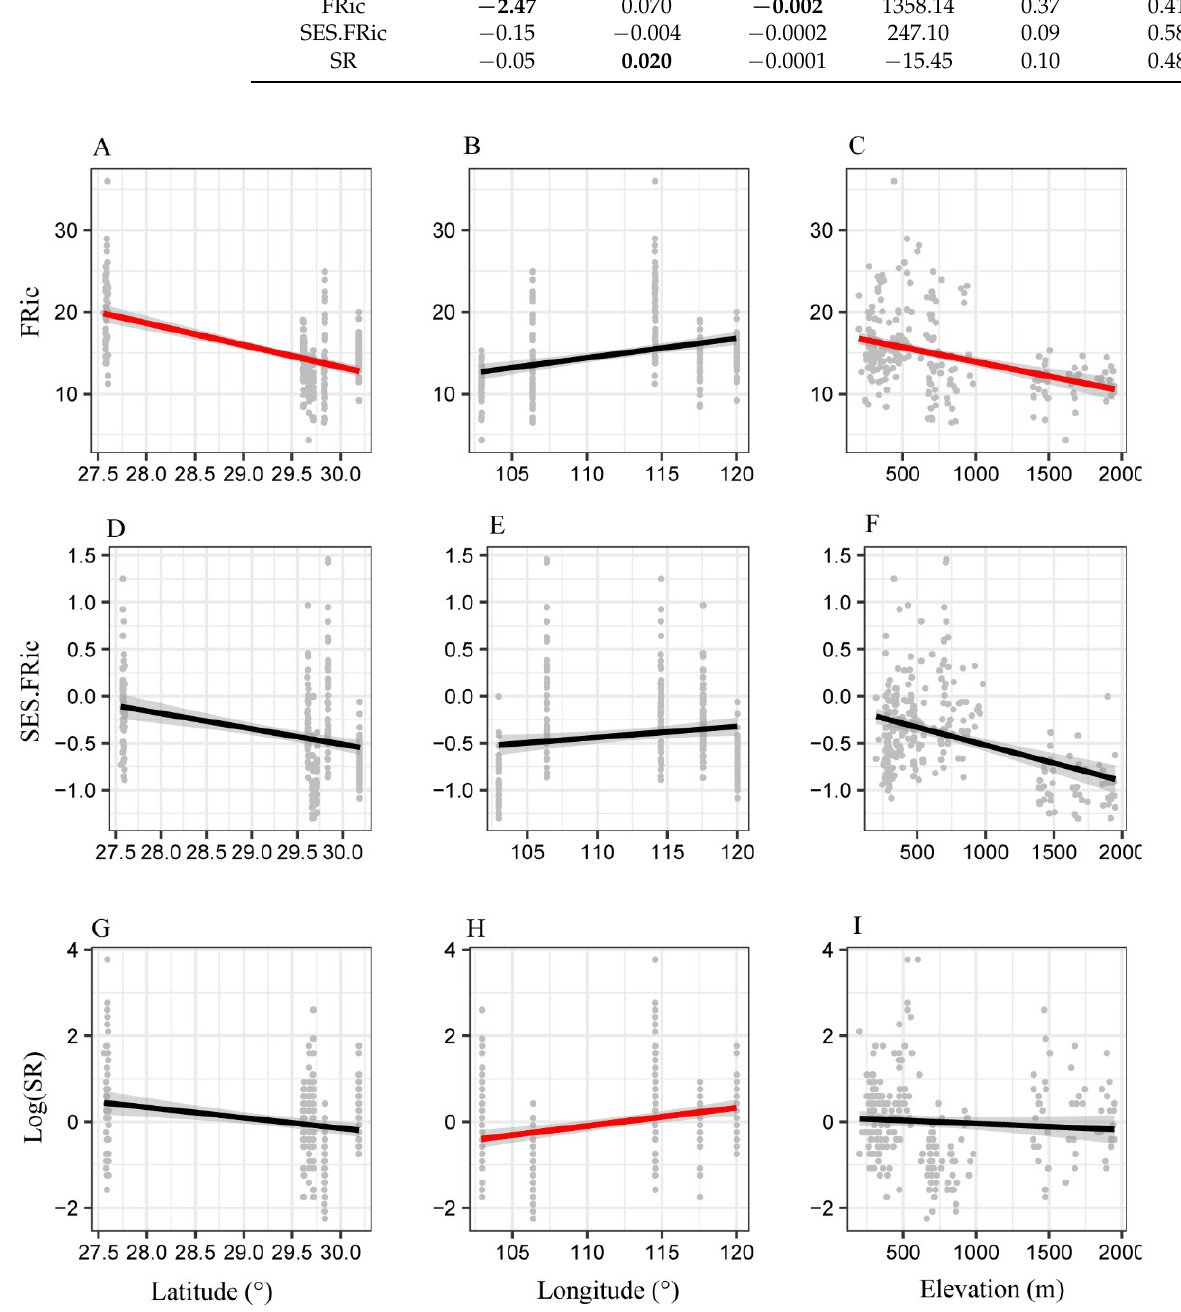
Figure 1. ( A – I ) Shifts in the functional richness (FRic), standardized effect of the functional richness (SES.FRic), and (log-transformed) species richness [log(SR)] along geographical gradients. ( A – C ) FRic, ( D – F ) SES.FRic, as well as ( G – I ) log(SR) across latitude, elevation, and longitude. The significance was tested by mixed linear models (see Table 2 for details on the models). Red lines represent significant linear regressions.